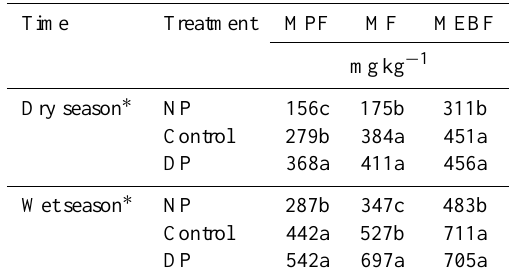
Table 4. Mean soil microbial biomass C of the top 20cm soil layer under different precipitation treatments in 2008 in three forests of Dinghushan Biosphere Reserve. Mean values within a column in each season followed by different lowercase letters have significant treatment differences at P < 0 . 05. MPF, Masson pine forest; MF, coniferous and broad-leaved mixed forest; MEBF, monsoon ever- green broad-leaved forest. NP, no precipitation; Control, natural precipitation; DP, double